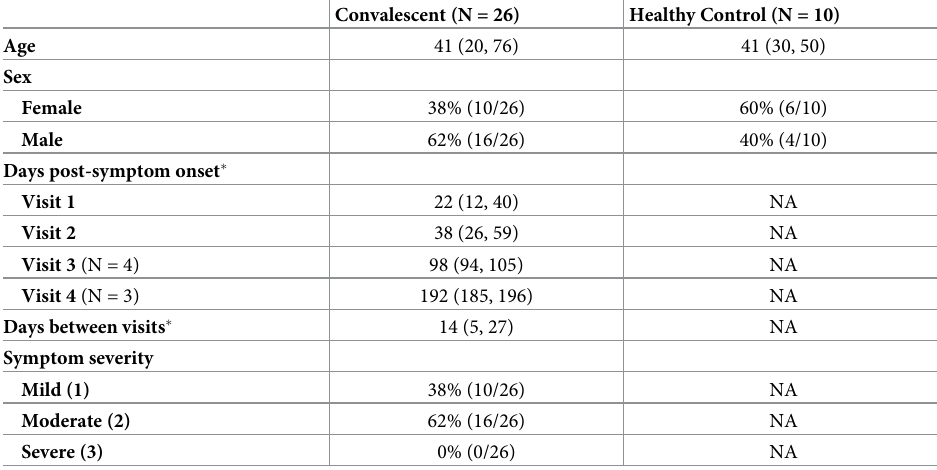
Table 1. Patient